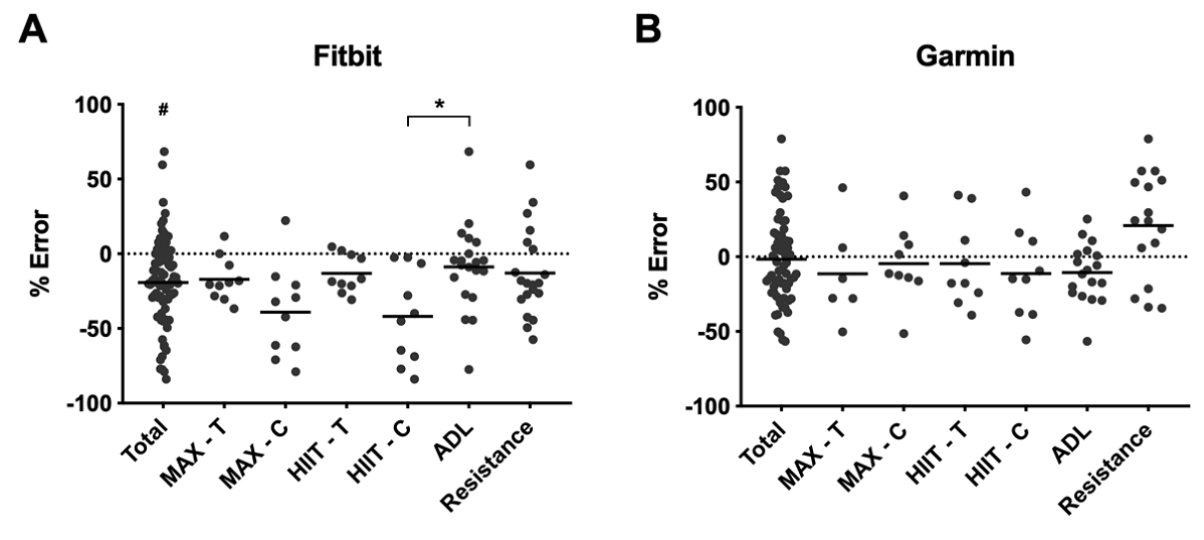
Figure 5. Percent relative error (RE) in energy expenditure (EE) across different exercise modalities for Fitbit (A) and Garmin (B). Negative bias in estimating EE is apparent across exercise modalities. The horizontal lines represent the mean. Asterisk indicates P =.03; # indicates P <.001 compared to Garmin. ADLs: activities of daily living, HIIT-C: high-intensity interval training-Cycle ergometer, HIIT-T: high-intensity interval training-Treadmill, MAX-C: MAX-Cycle ergometer, MAX-T: